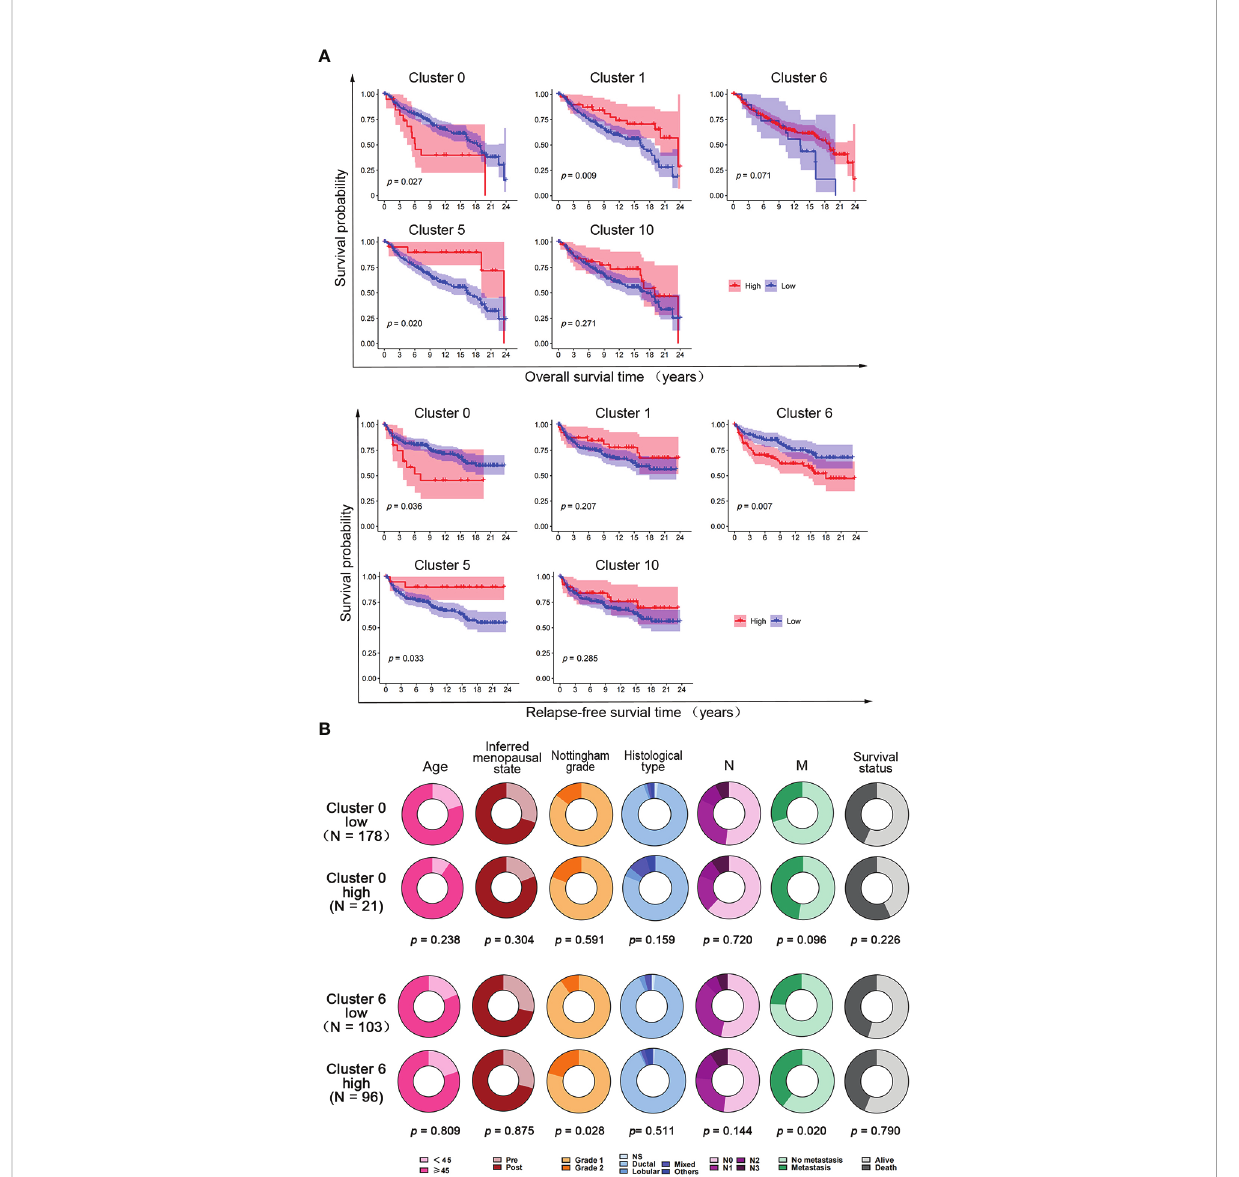
FIGURE 6 The effect of hypoxia-dependent spatial subgroup scores of cluster 0, cluster 1, cluster 6, cluster 5, and cluster 10 on survival and clinicopathological factors in human claudin-low breast cancer. (A) Kaplan – Meier OS and RFS survival plot of hypoxia-dependent spatial cluster score of cluster 0, cluster 1, cluster 6, cluster 5, and cluster 10 in the claudin-low subtype. (B) The distribution of clinicopathologic factors for low and high groups of cluster 0 gene score and cluster 6 gene score in human claudin-low breast cancer. Pie charts indicated the chi-squared test